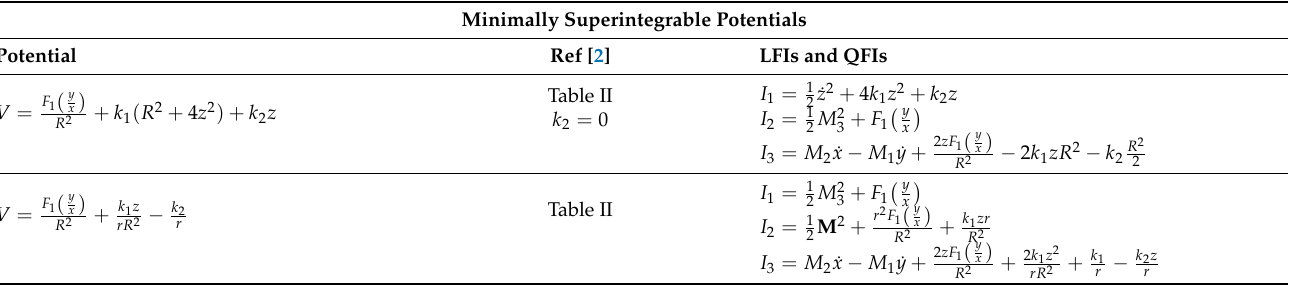
Table 6. Minimally superintegrable potentials V ( x , y , z ) in E 3 that admit QFIs of the type I ( 1,1 )